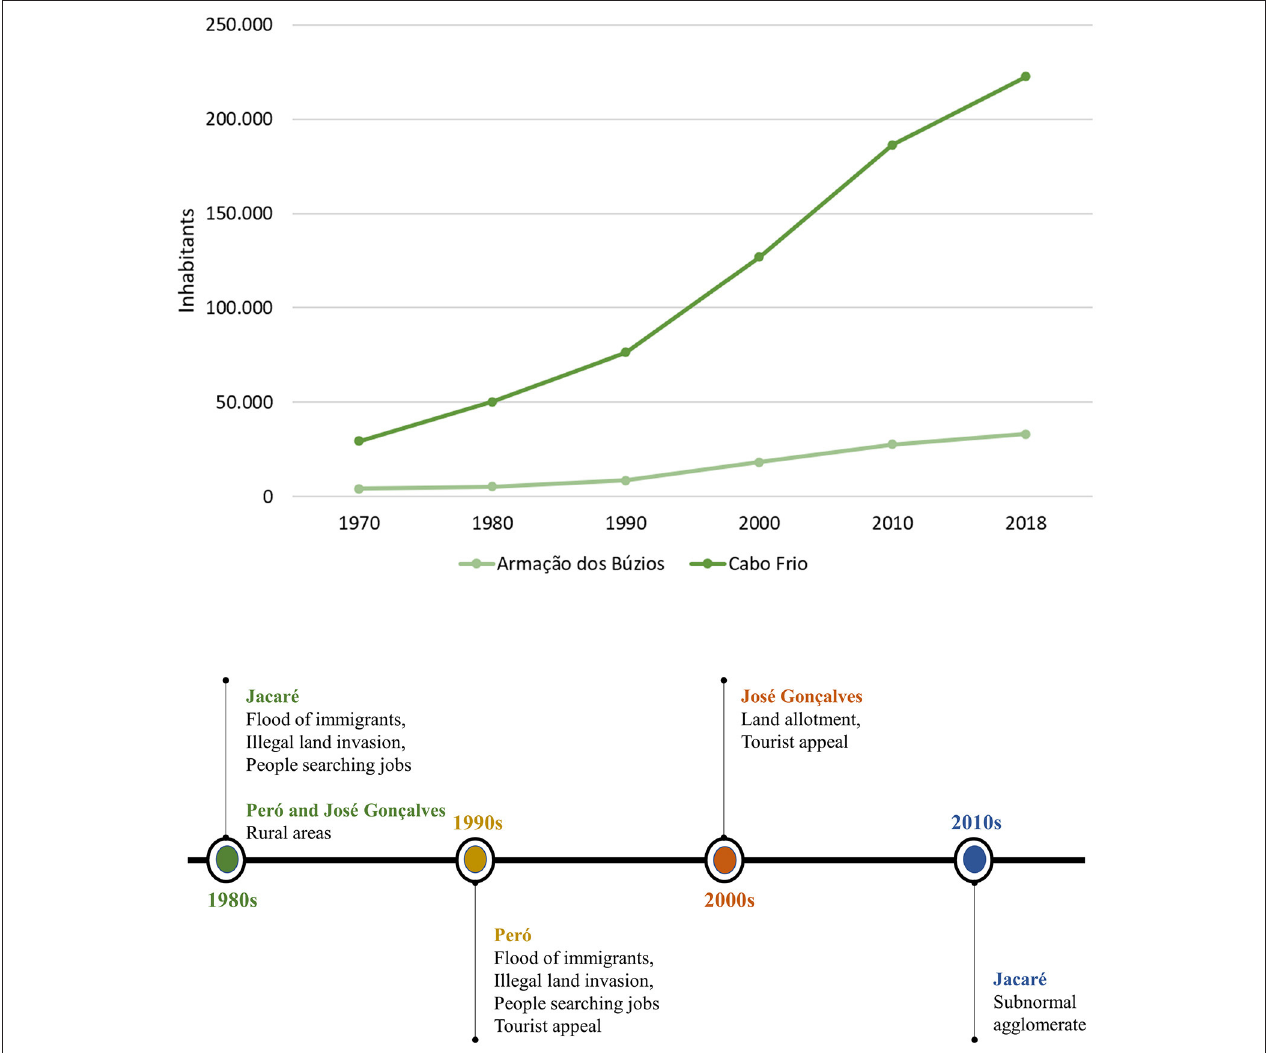
FIGURE 1 | Demographic variation in the Cabo Frio and Armação dos Búzios municipalities (Fundação CEPERJ., 2013; IBGE, 2010), and summarizing demographic and urban growth in the studied communities.